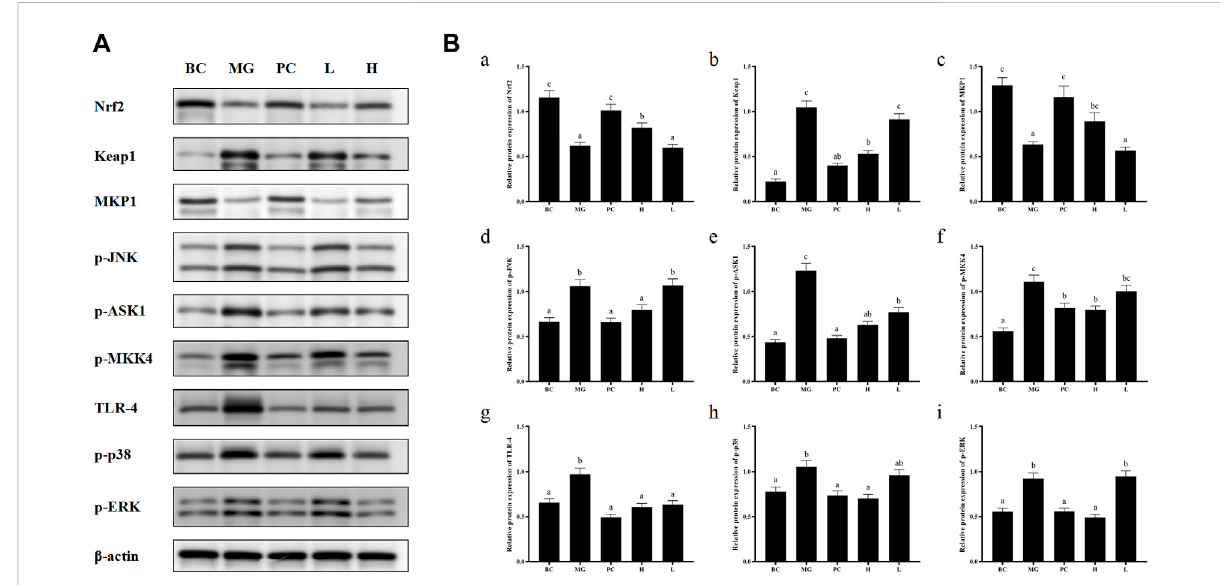
FIGURE 8 (A) BRP-SeNPsprotectedmicefromCCl